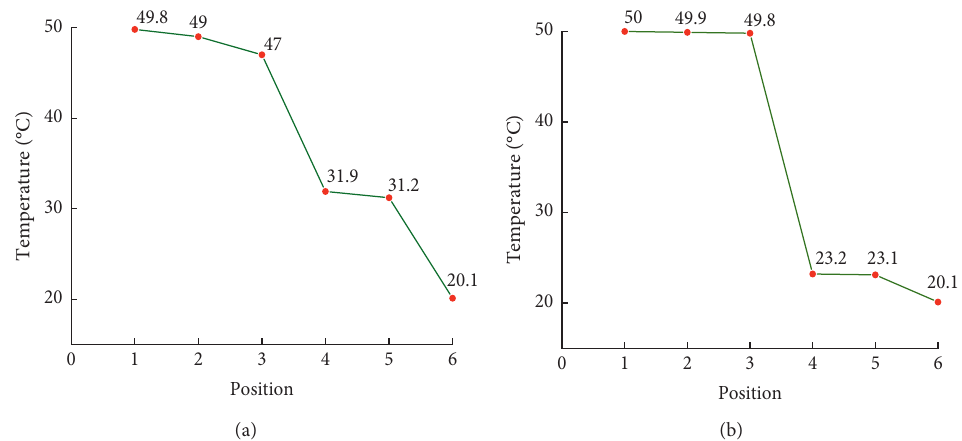
Figure 16: Temperature gradient change of the semirigid finish layer. (a) Near anchor bolt. (b) Away from the anchor bolt.